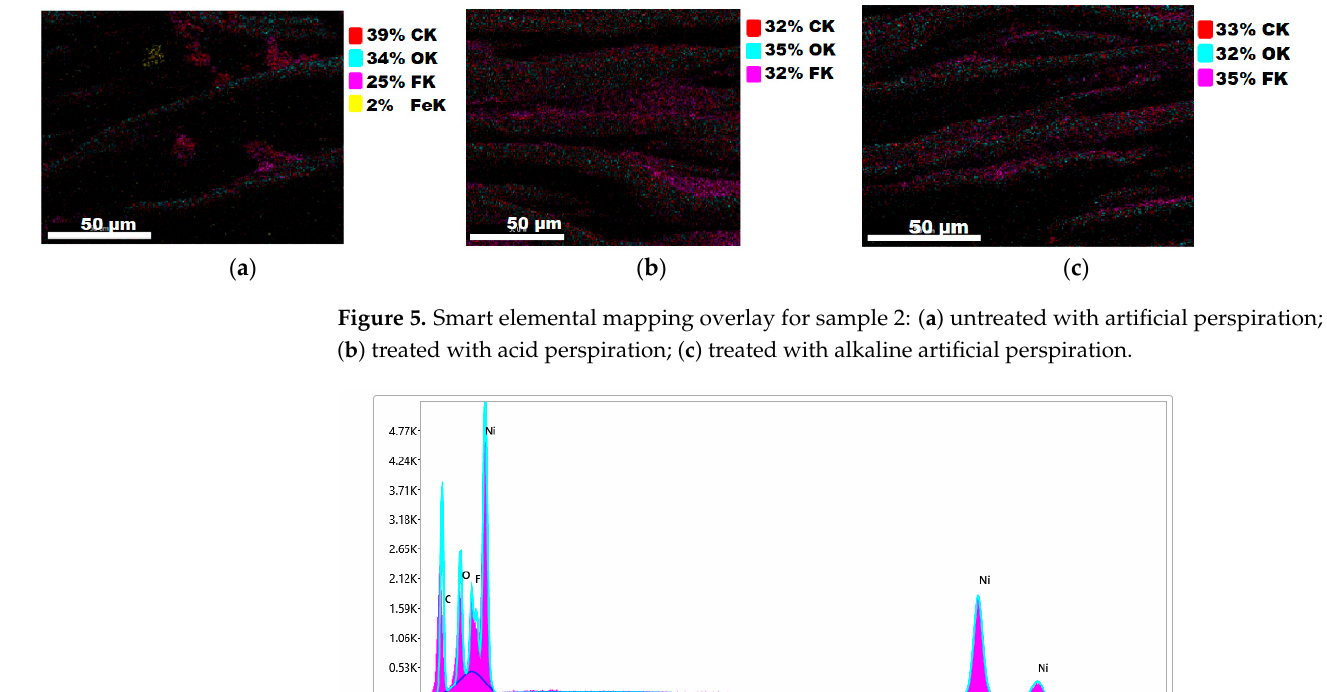
conductive paste).